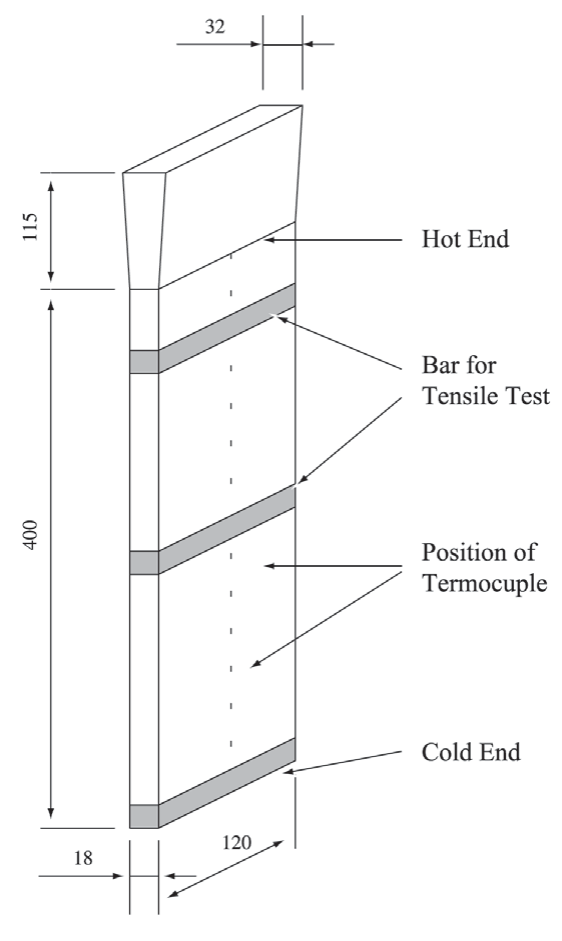
Figure 1. Diagram of the plate. The dots indicate the position of thermocouples used for measuring the cooling